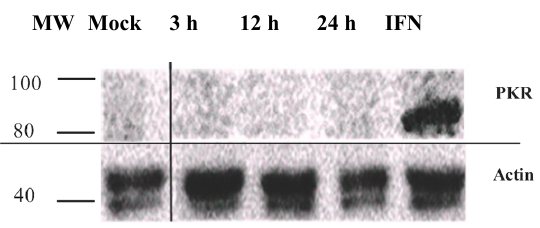
Figure 3. PKR expression in cells infected with infectious pancreatic necrosis virus assessed by Western blot analysis. The cells were harvested at indicated times (hours; h) following infection. IFN = cells were treated with interferon α for four days prior to sampling. MW = molecular weight.